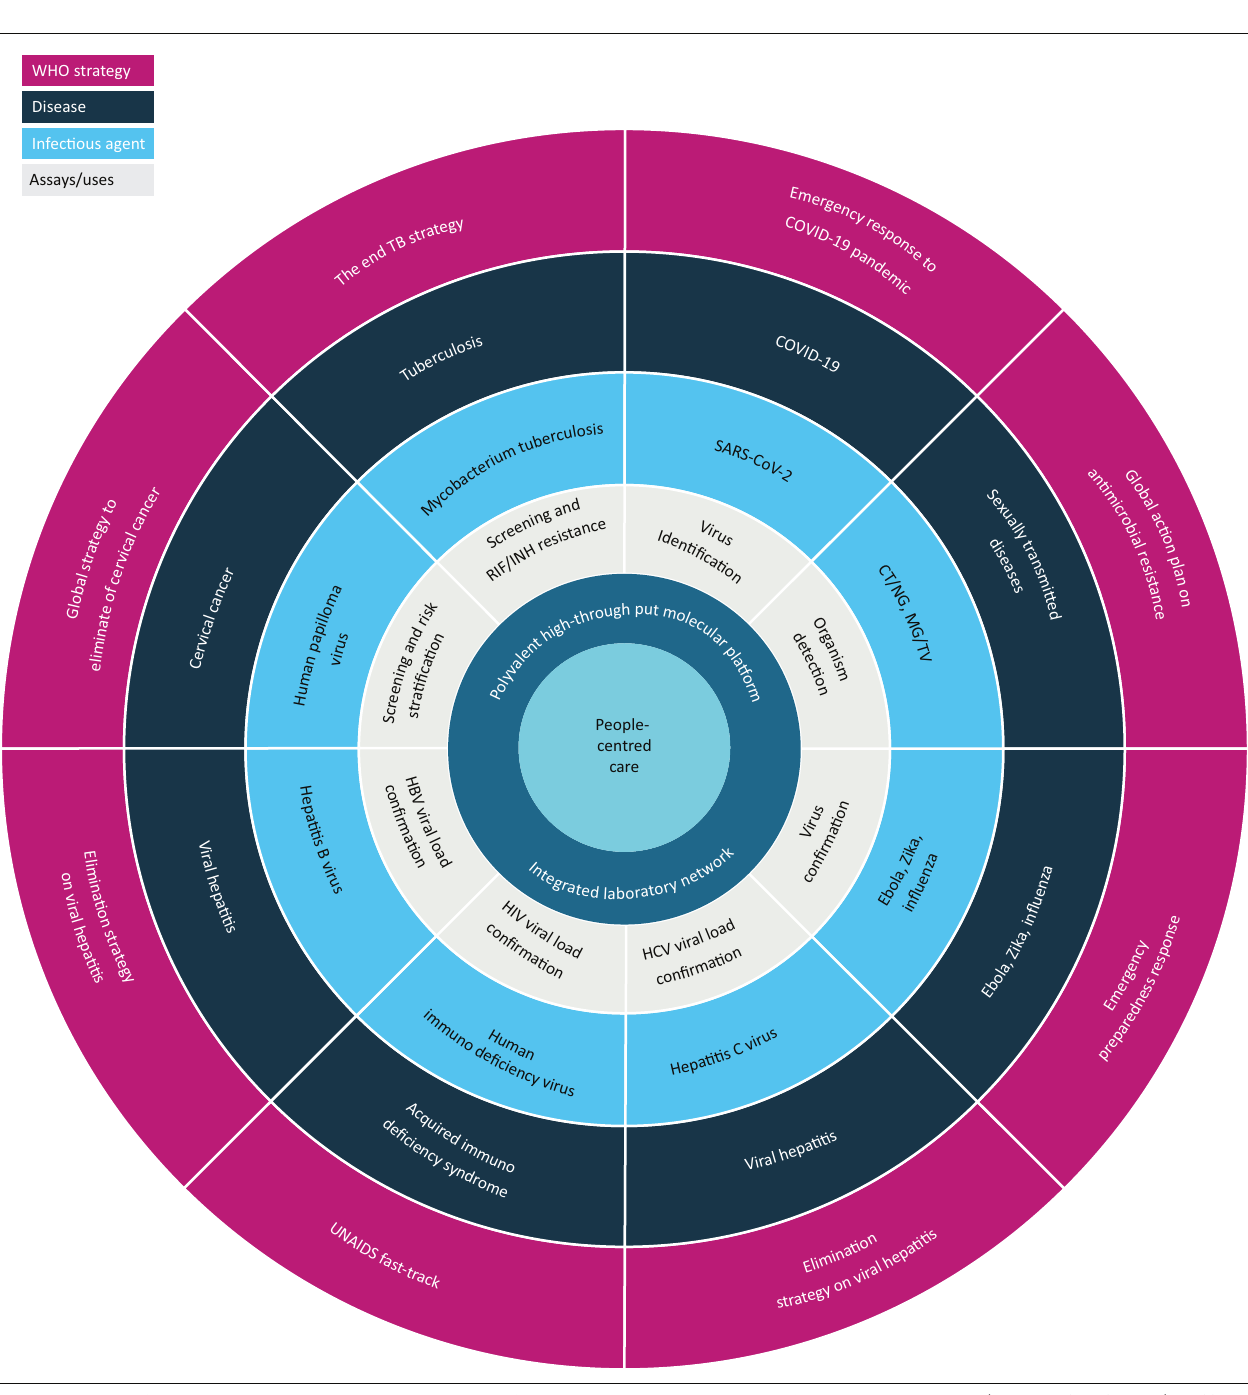
FIGURE 2: Link between global health strategies and automated molecular